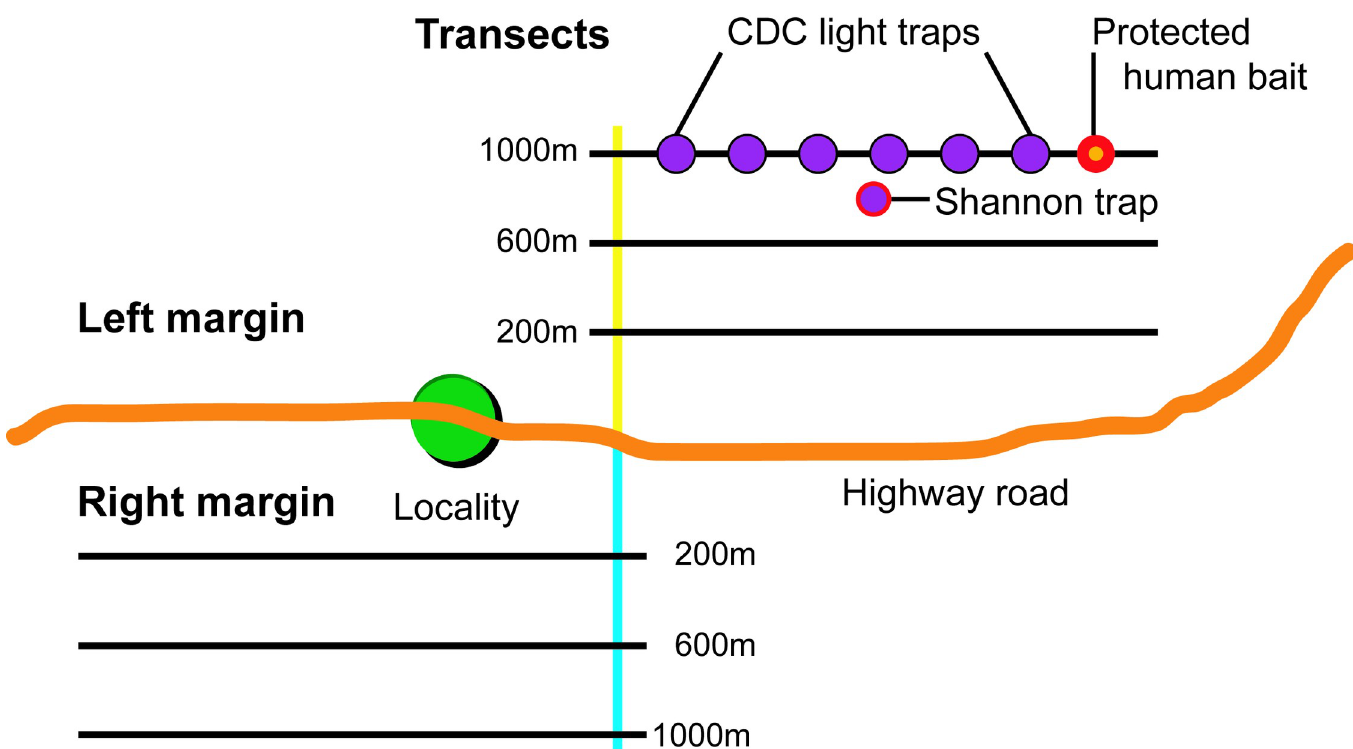
Fig 2. Sand fly trapping approach used in this study. At each study site, collections were performed along three transects (200 m, 600 m and 1,000 m) at the left and right margins of the Interoceanic highway. Six CDC light traps where placed on each transect every 50 m, a Shannon trap was placed at a midpoint between the 600 m and 1,000 m transects and a protected human bait at one end of the